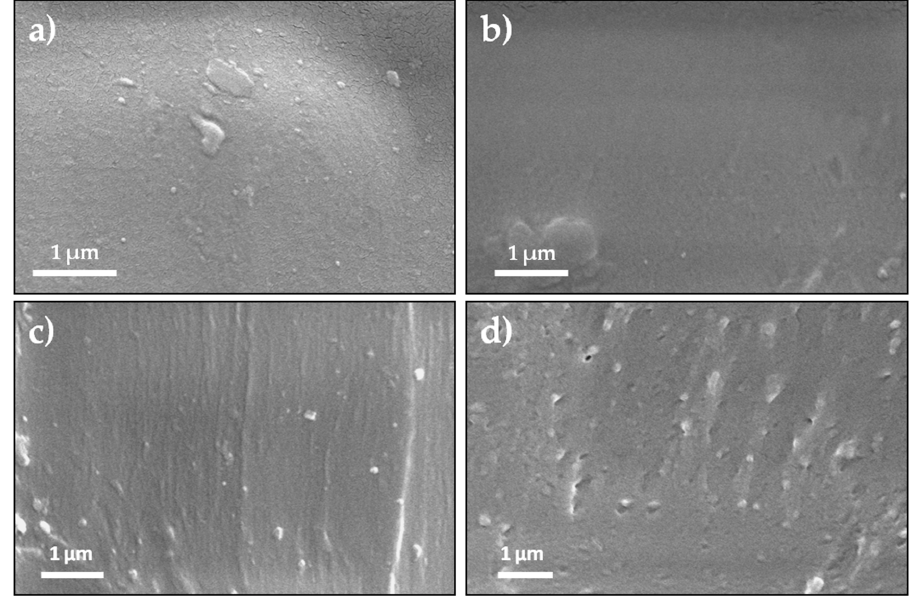
Figure 5. SEM observations of: ( a ) PLAV, ( b ) PLAR, ( c ) PLAR-1YMN and ( d ) PLAR-3YMN. (10,000× magnifications). (10,000 ×